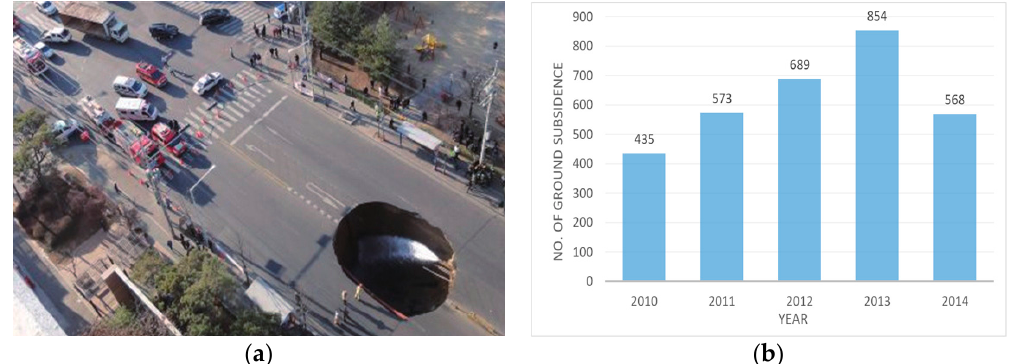
Figure 1. ( a ) A snapshot of ground subsidence in Seoul and ( b ) number of ground subsidence that occurred in Seoul between 2010 and 2014.